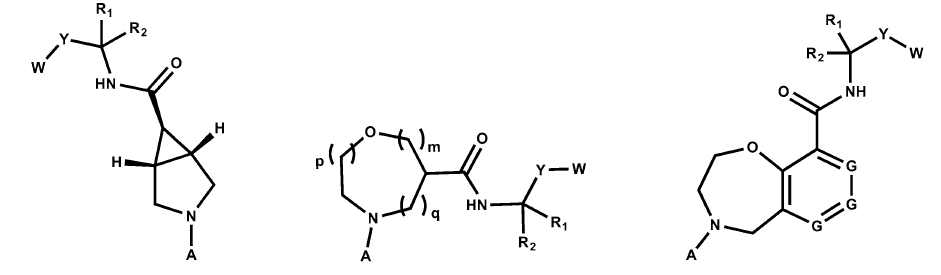
Fig. 2 New proposed agonist series for sst . From left to right: MCL 4 (3-aza-bicyclo[3.1.0]hexane-6-carboxylic acid amide), PCT (mor- pholine and 14-oxazepane amides), and EP (aryl and heteroaryl- fused tetrahydro-1,4-oxazepine amides). A can be a C -alkyl or a 1-6 hydrogen, R and R can be C -alkyl, C -alkyl, or hydrogens, R 1 2 1-6 3-6 1 or